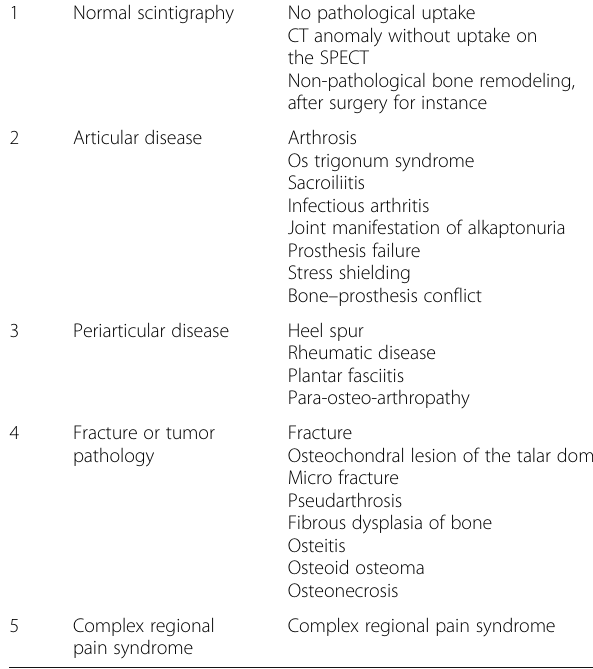
Table 4 Inter-observer agreement between xSPECT Bone® and